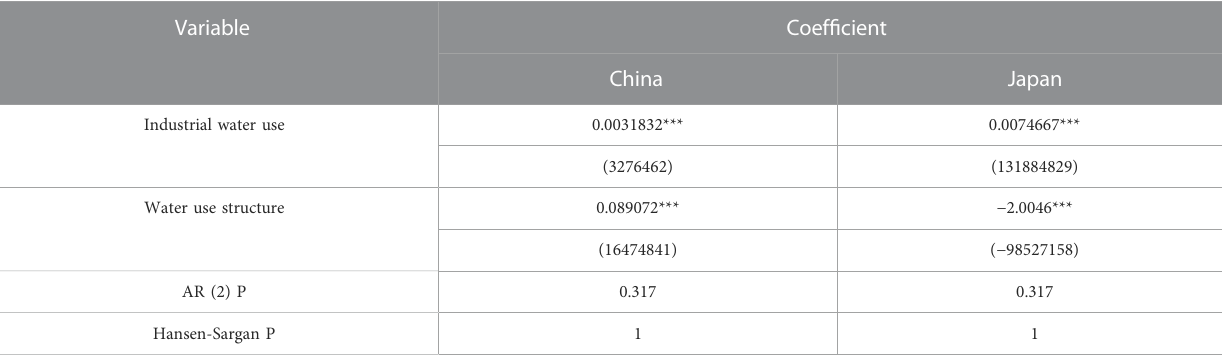
TABLE 4 Relationship between water use and stock market volatility.